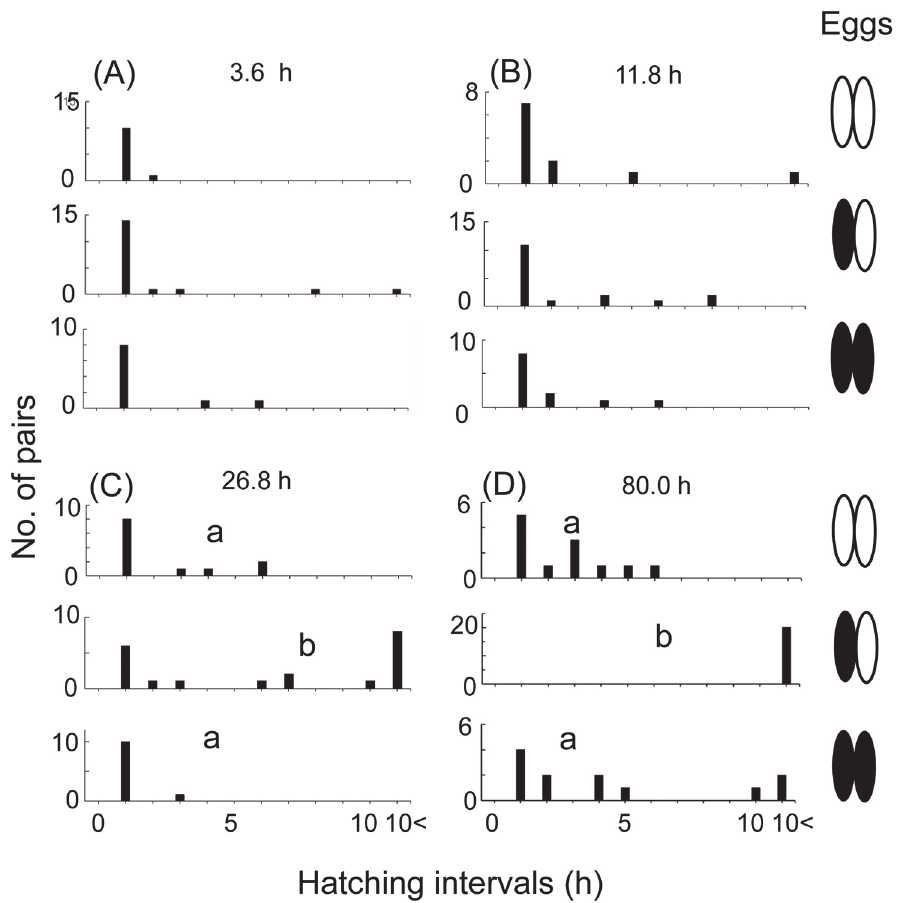
Fig. 12. The frequency distributions of hatching intervals for Locusta migratoria egg pairs derived from different (middle panel) and from the same pods (top and bottom panels). For explanation of the experimental design, see Fig. 11. Different lower-case letters indi- cate significant differences in mean values at the 5% level with Steel-Dwass test. The diagrams on the right of the figure show combina- tions of eggs from two pods expressed as white and black eggs,